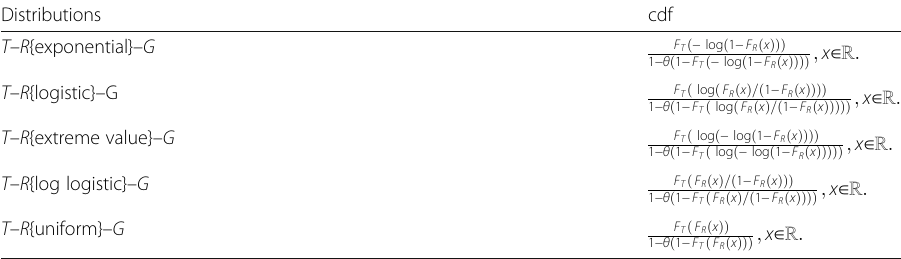
Table 5 Different T – R { Y } – G distributions Distributions cdf